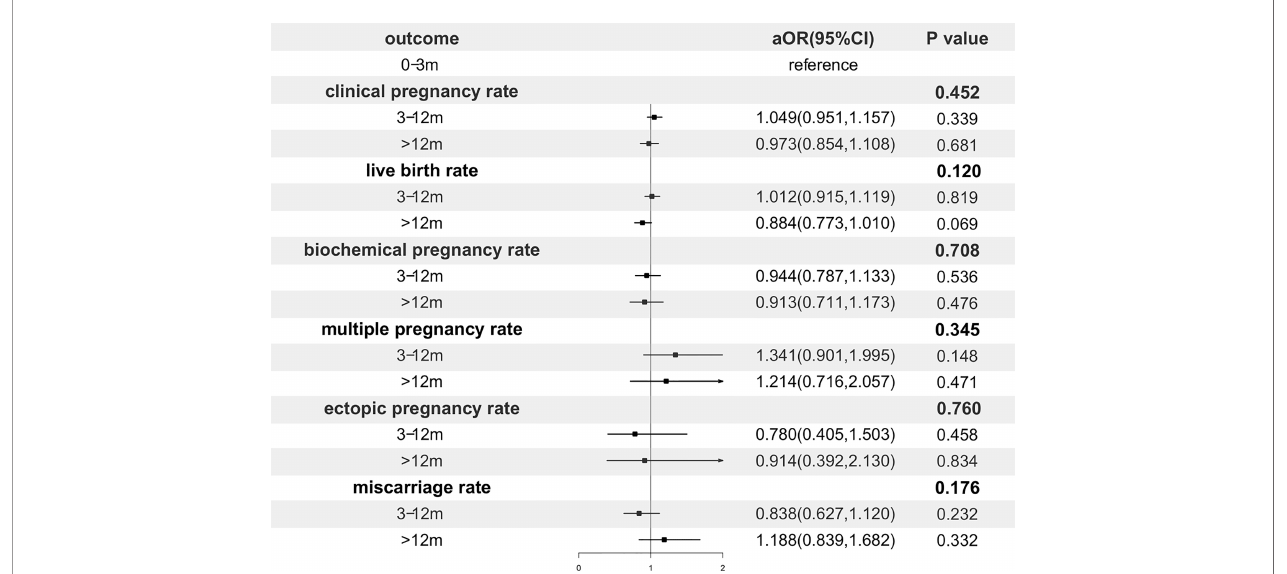
FIGURE 2 | Forest plot of adjusted odds ratio of pregnancy outcomes. OR, odds ratio; CI, con fi dence interval.